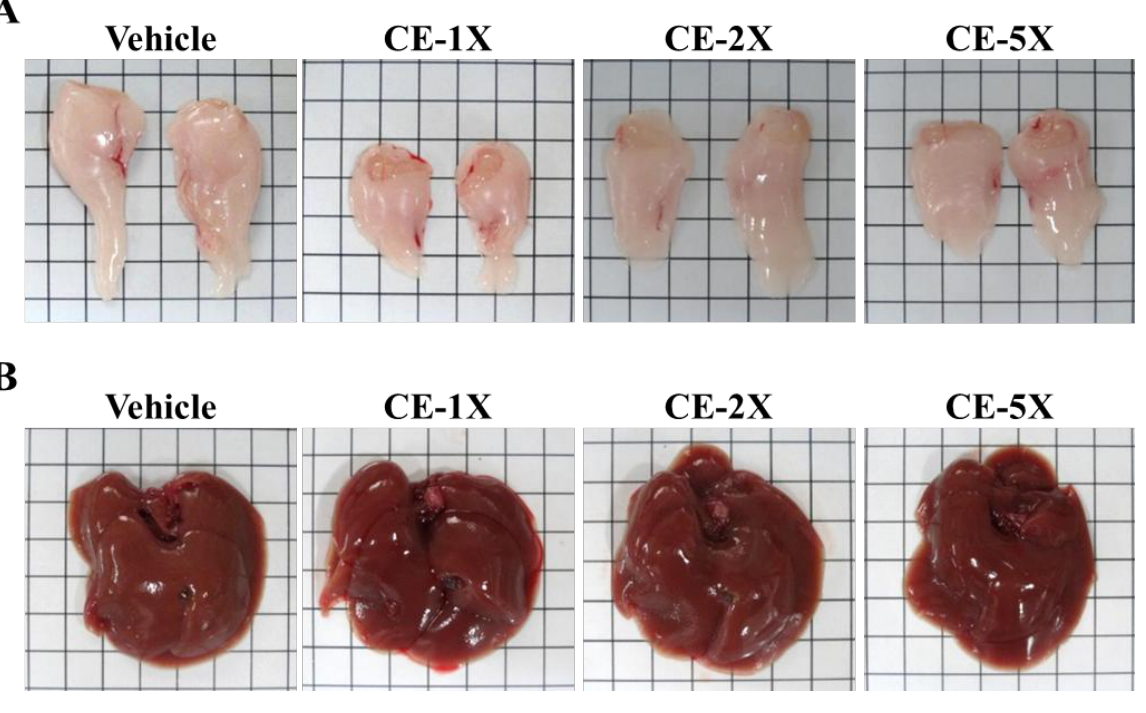
Figure 6. Effect of CE supplementation on epididymal fat pad (EFP; ventral view) ( A ) and liver ( B ) in mice seen by